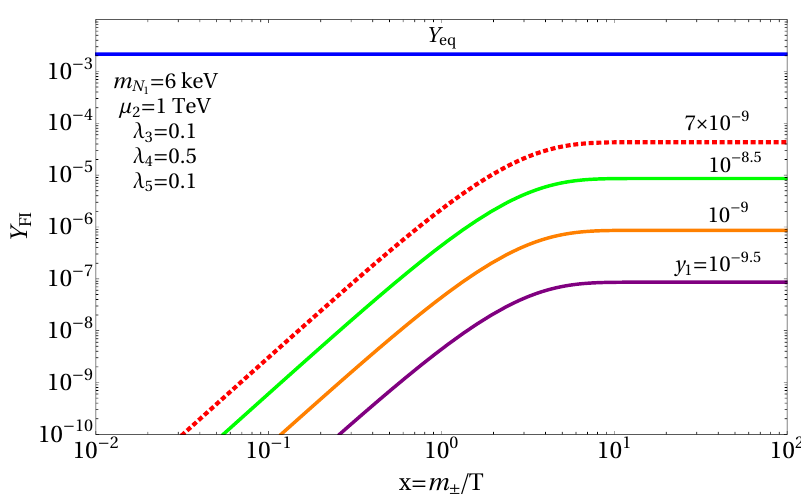
Figure 1. DM freeze-in yield as a function of x = m (cid:6) =T , shown for di(cid:11)erent values of y 1 . We have chosen the bare mass parameter (cid:22) 2 = 1000 GeV and (cid:12)xed the quartic terms to (cid:21) 3 = (cid:21) 5 = 0 : 1 and (cid:21) 4 = 0 : 5. The parameter choice of the red dashed curve leads to (cid:10) h 2